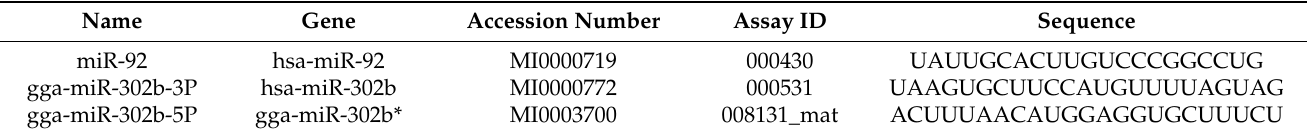
Table 2. Primers used at the miRNA